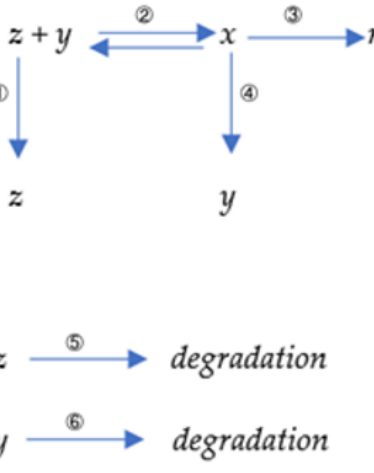
Figure 1. A simple diagram of host-virus interaction. Here, x denotes the number of antibody–antigen (virus) complexes, y denotes the total number of antibodies, and z denotes the number of viruses. Six processes are displayed in our model. The first reaction represents the virus’s proliferation or replication with a reaction constant k 1 . The second reaction represents the binding reaction between virus and antibody, with a forward reaction constant k 2 and reverse constant k − 2 . The third reaction represents removing the antibody–virus complex with a reaction constant k 3 with the help of natural killer (NK) cells [32]. The fourth reaction represents the induction of a new antibody by the antibody–virus complex with a kinetic constant k 4 . In immunology, those virus–antibody complexes are on the surface of B-cells since the antibodies are initially produced by B-cells and will attach to the plasma membrane of B-cells. Those complexes would further bind to the helper cells because the antibody has another structure binding region toward those receptors. Those helper cells will present the antigen part, a virus in this case, to the T-cells. The physical placement should be such that B-cells bind to those helper cells and further present themselves close to T-cells. The T-cells will handle those antigen substances; if those substances are not self-originated, they will secrete signal molecules to promote the proliferation or division of B-cells that attach to them. Therefore, B-cells finally proliferate, along with the antibodies their B-cells generate. The fifth reaction represents the degradation of the virus with a constant k 5 . The sixth reaction represents the degradation of antibodies with a rate constant k 6 .